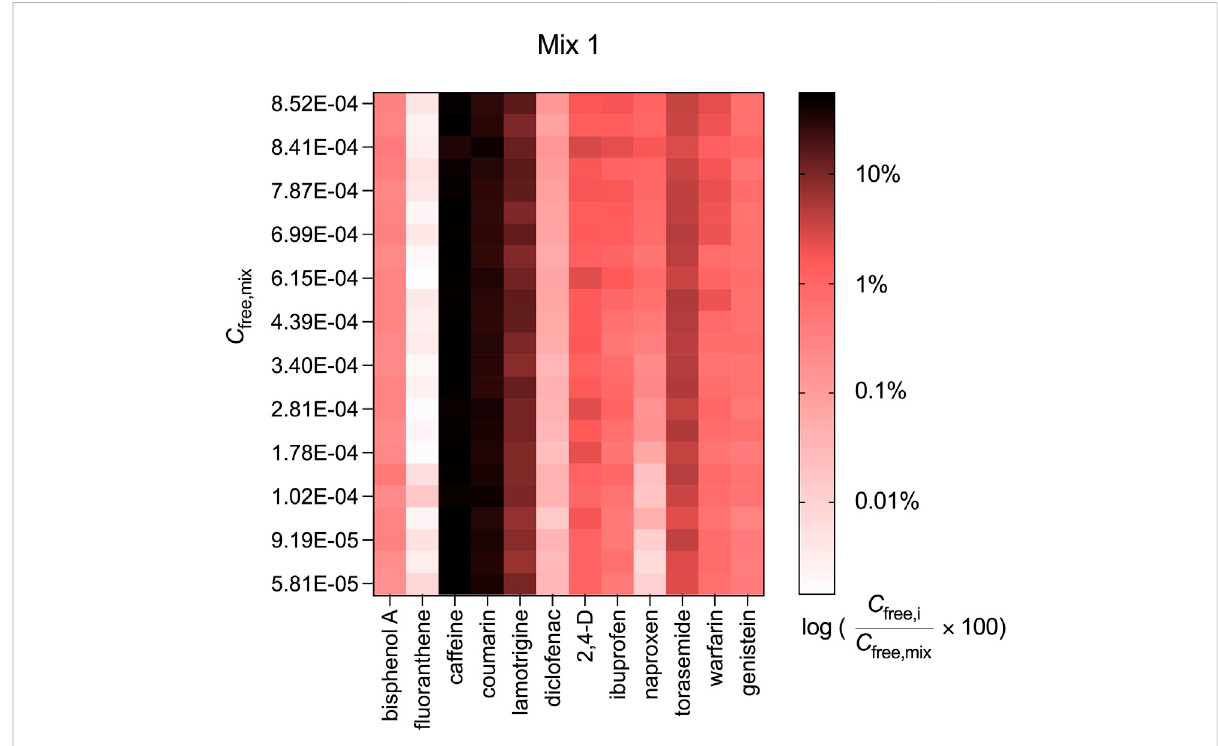
FIGURE 4 Contribution of the measured freely dissolved concentrations of the individual chemicals ( C free,i ) to the freely dissolved concentrations of Mix 1 ( C free,mix